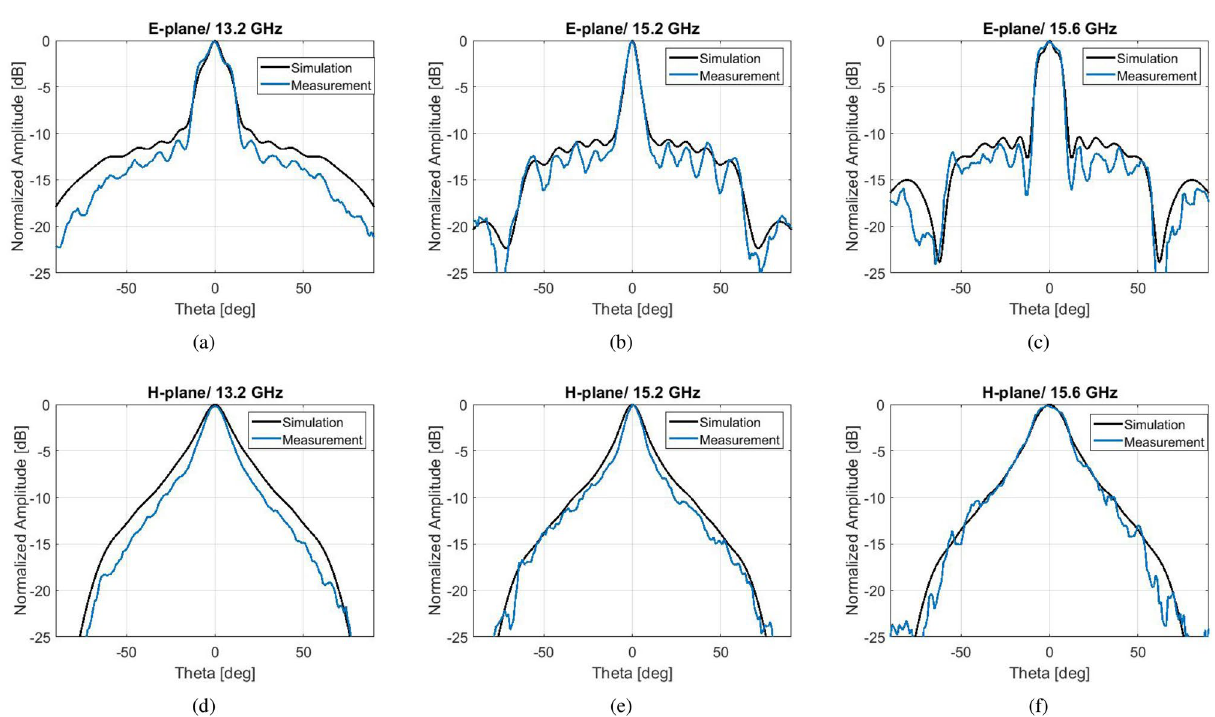
Figure 9. Measured radiation patterns of the hybrid antenna with flat gain and comparison with